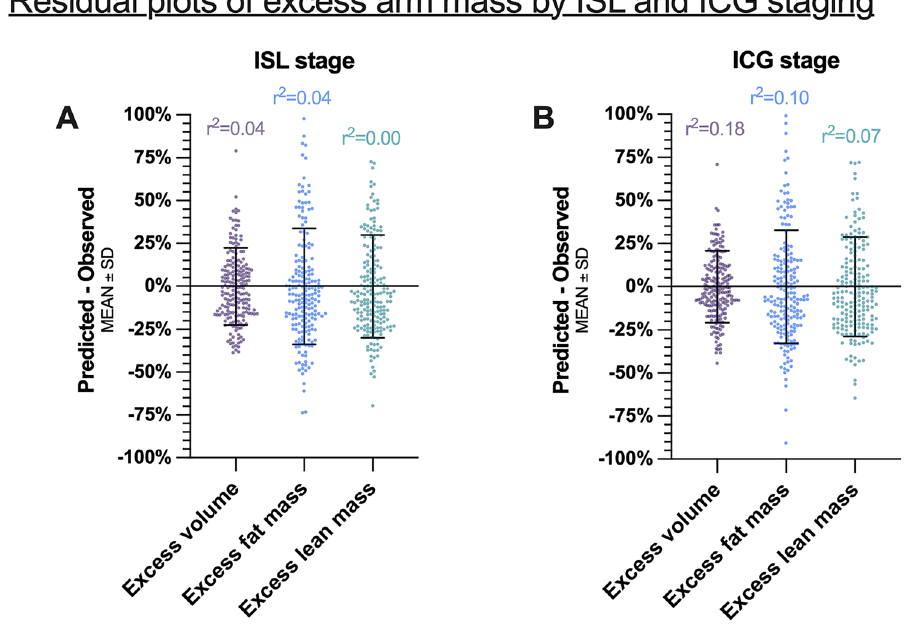
Figure 3. This figure shows the residuals of predicted minus observed excess volume, fat, and lean mass by ( A ) ISL stage and ( B ) ICG